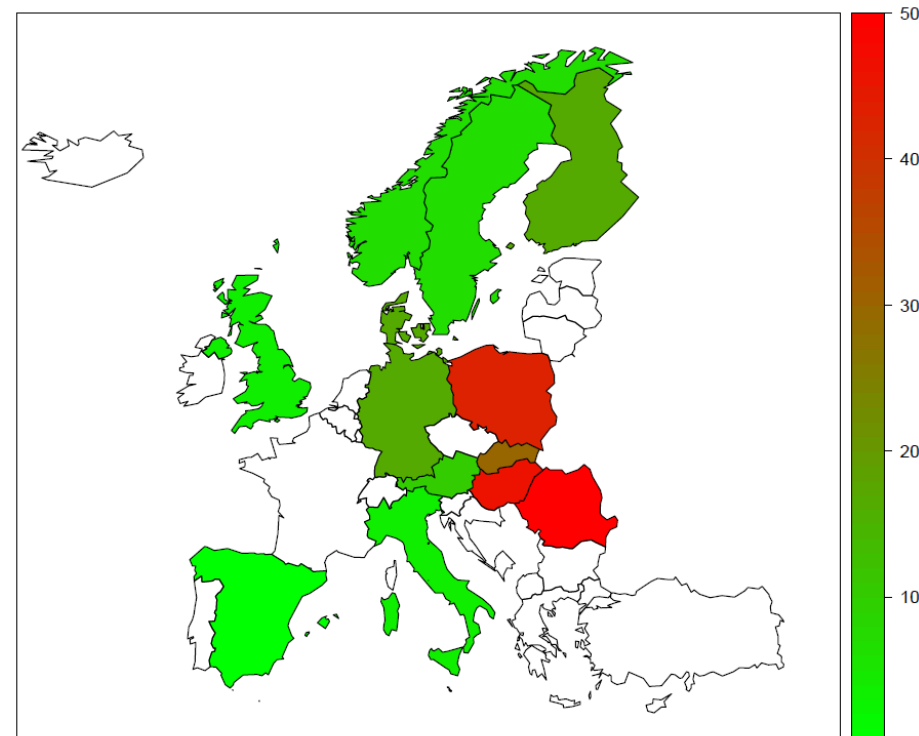
Figure 1. Rough estimates of major lower limb amputations crude incidences (per 10 5 ) across Europe. In countries where data only for diabetic patients were available, incidence rates were doubled.